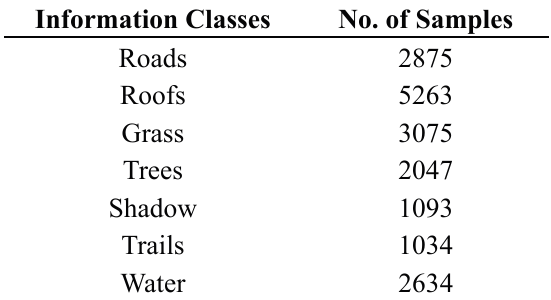
Table 12. The numbers of samples for the reference data in the HYDICE DC Mall dataset.